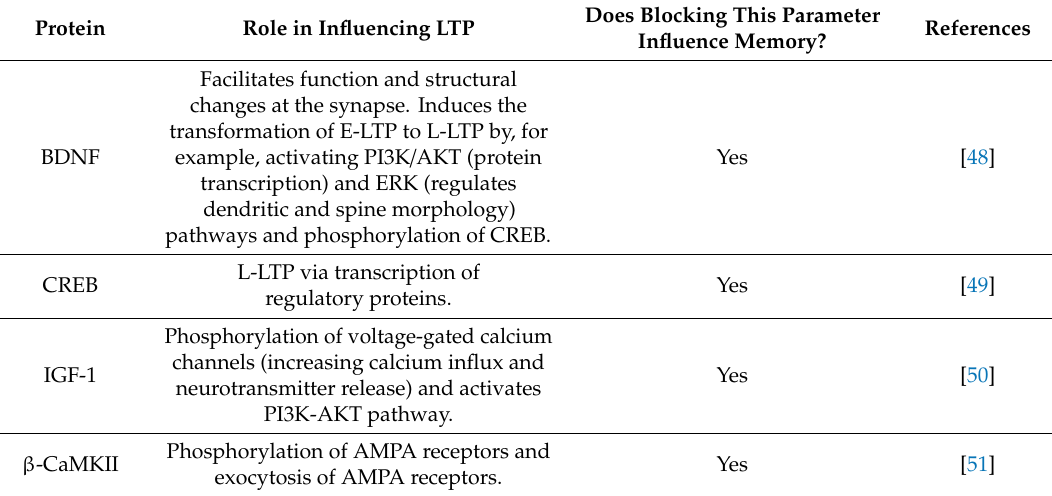
Table 1. Role of key proteins and receptors in influencing long-term potentiation.